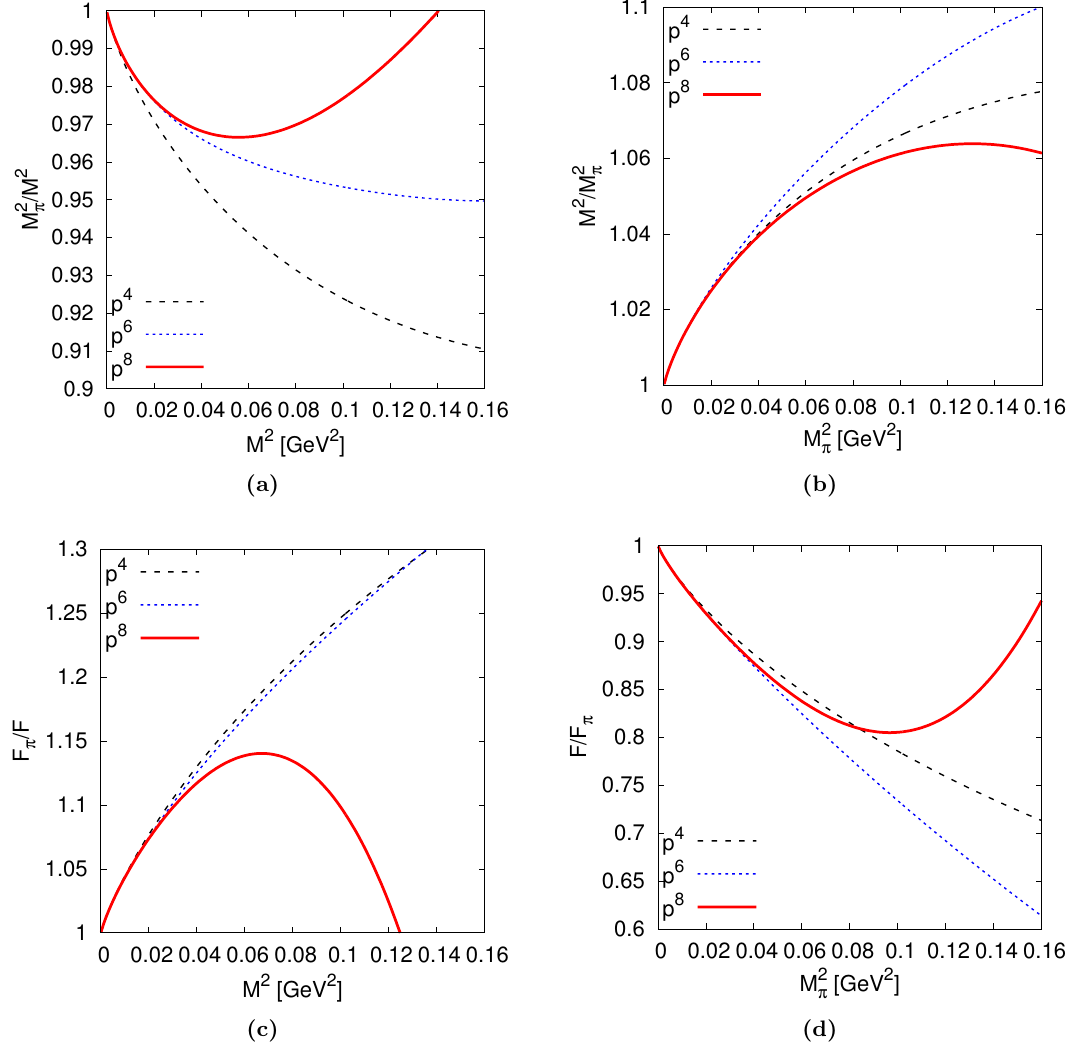
Figure 2. (a) The x -expansion for the mass, (b) the x -expansion for the decay constant, (c) the (cid:24) -expansion for the mass, (d) the (cid:24) -expansion for the decay constant at NLO, NNLO and NNNLO. LO is constant at 1 for all four